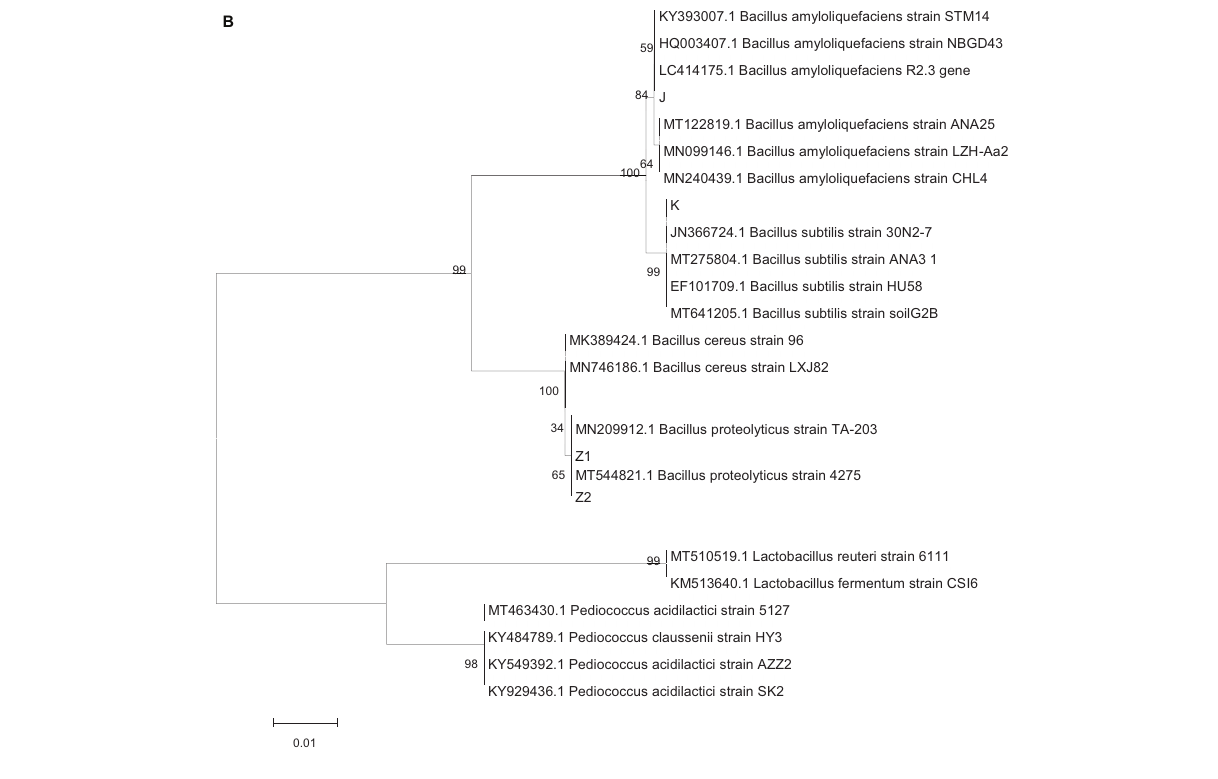
FIGURE 1 | (A) The diagram shows the results of Gram staining for four isolates: Z1 and Z2 ( Bacillus proteolyticus ), J ( Bacillus amyloliquefaciens ), and K ( Bacillus subtilis ). (B) Phylogenetic tree constructed by using a neighbor-joining method on the basis for 16S rRNA gene sequences. J ( Bacillus amyloliquefaciens ), K ( B. subtilis ), Z1 and Z2 ( B. proteolyticus